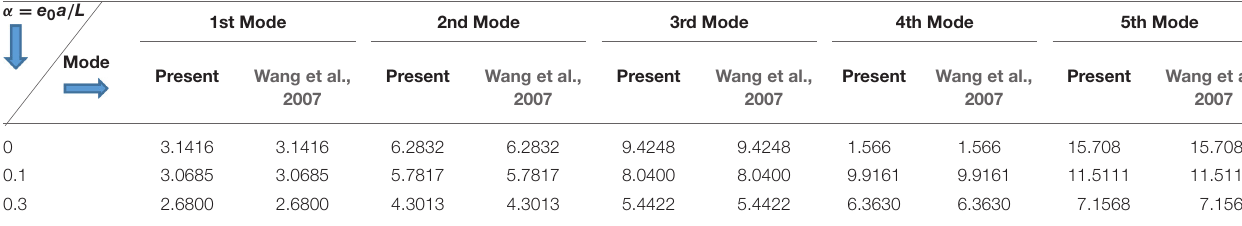
√ λ for SS case. (cid:16) (cid:17)